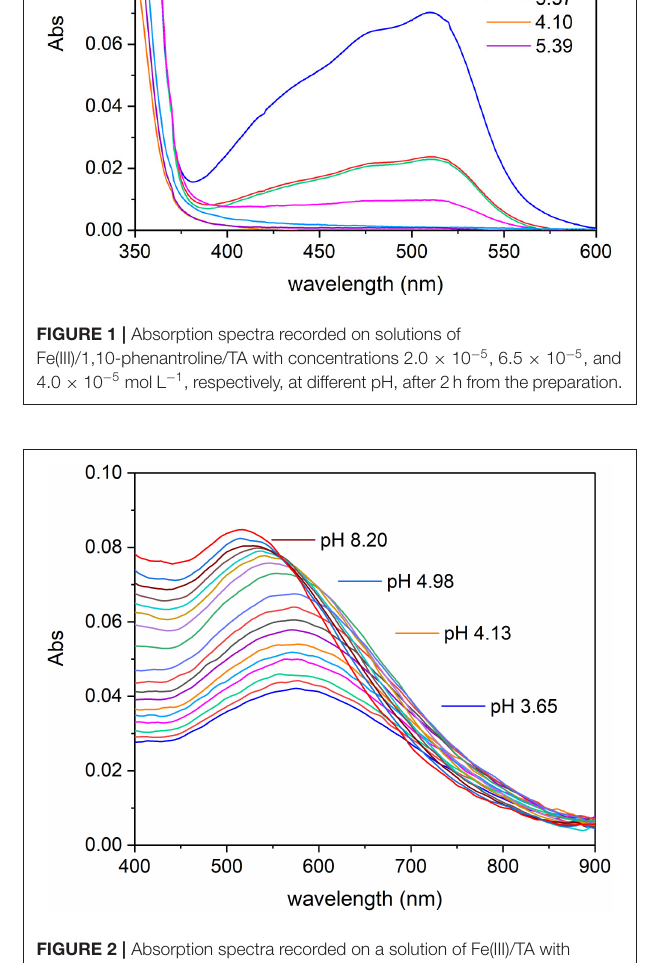
FIGURE 2 | Absorption spectra recorded on a solution of Fe(III)/TA with concentration 2.00 × 10 − 5 and 2.01 × 10 − 5 mol L − 1 , respectively, at different pH